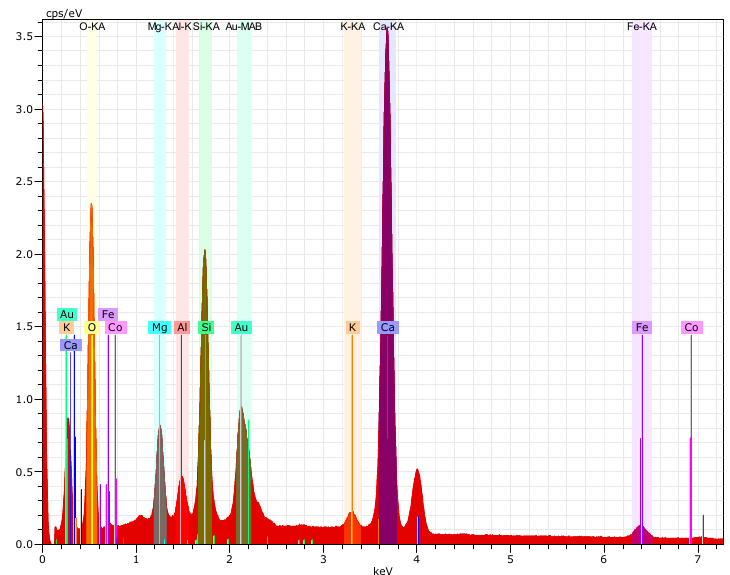
Figure 3. EDS spectrum of the sample from Figure 1e.